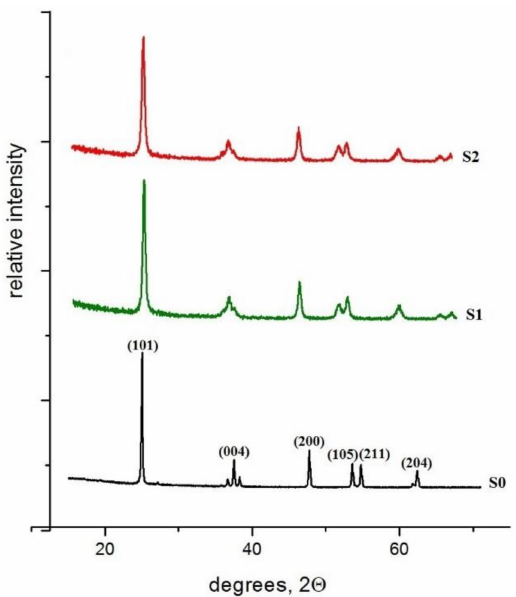
Figure 1. XRD pattern of catalysts, S1—green line, S2—red line; S0—black